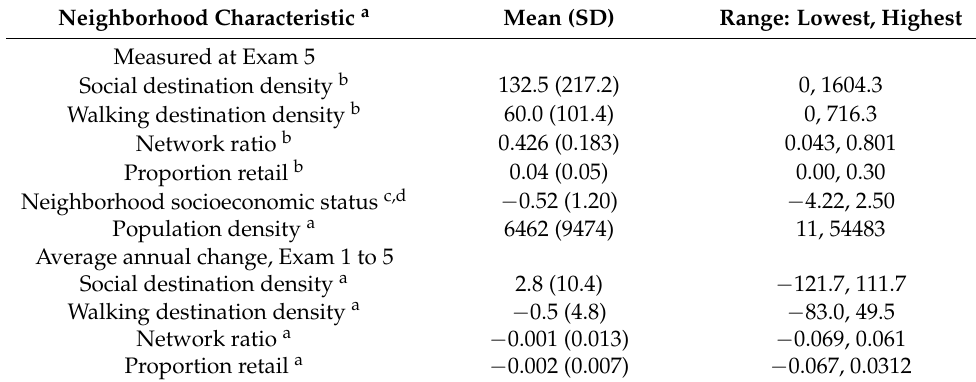
Table 3. Neighborhood